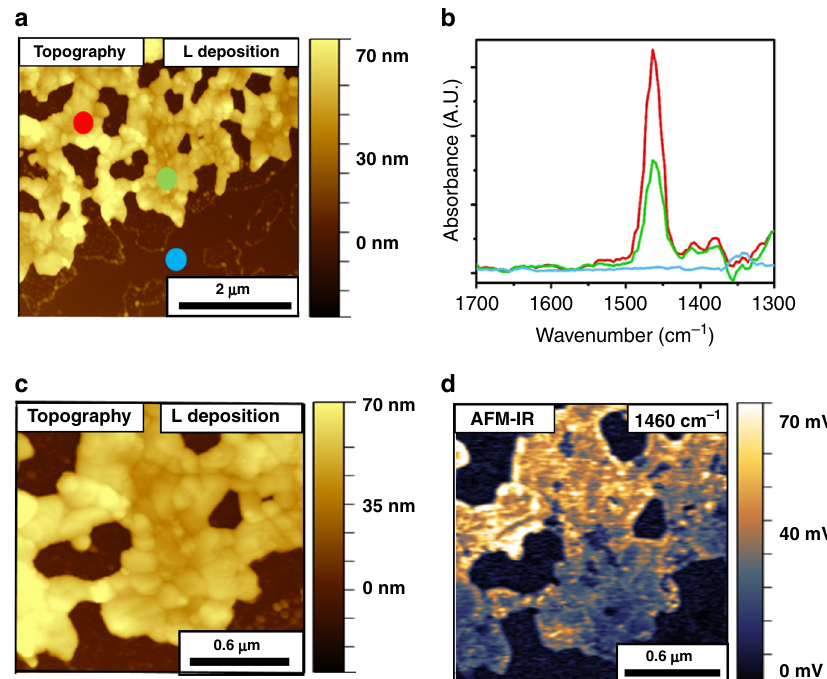
Fig. 6 AFM-IR measurements of EC-deposited NO 2 -NHCs on Au fi lm following exposure to one LSV cycle. AFM topography ( a ) and AFM-IR point spectra ( b ) of EC-deposited NO 2 -NHCs after one LSV cycle. The vibrational signals were acquired at different locations as indicated by dots with corresponding colors in the AFM topography image. Higher magni fi cation AFM topography image and the corresponding AFM-IR image at 1460 cm − 1 are shown in c and d , respectively.